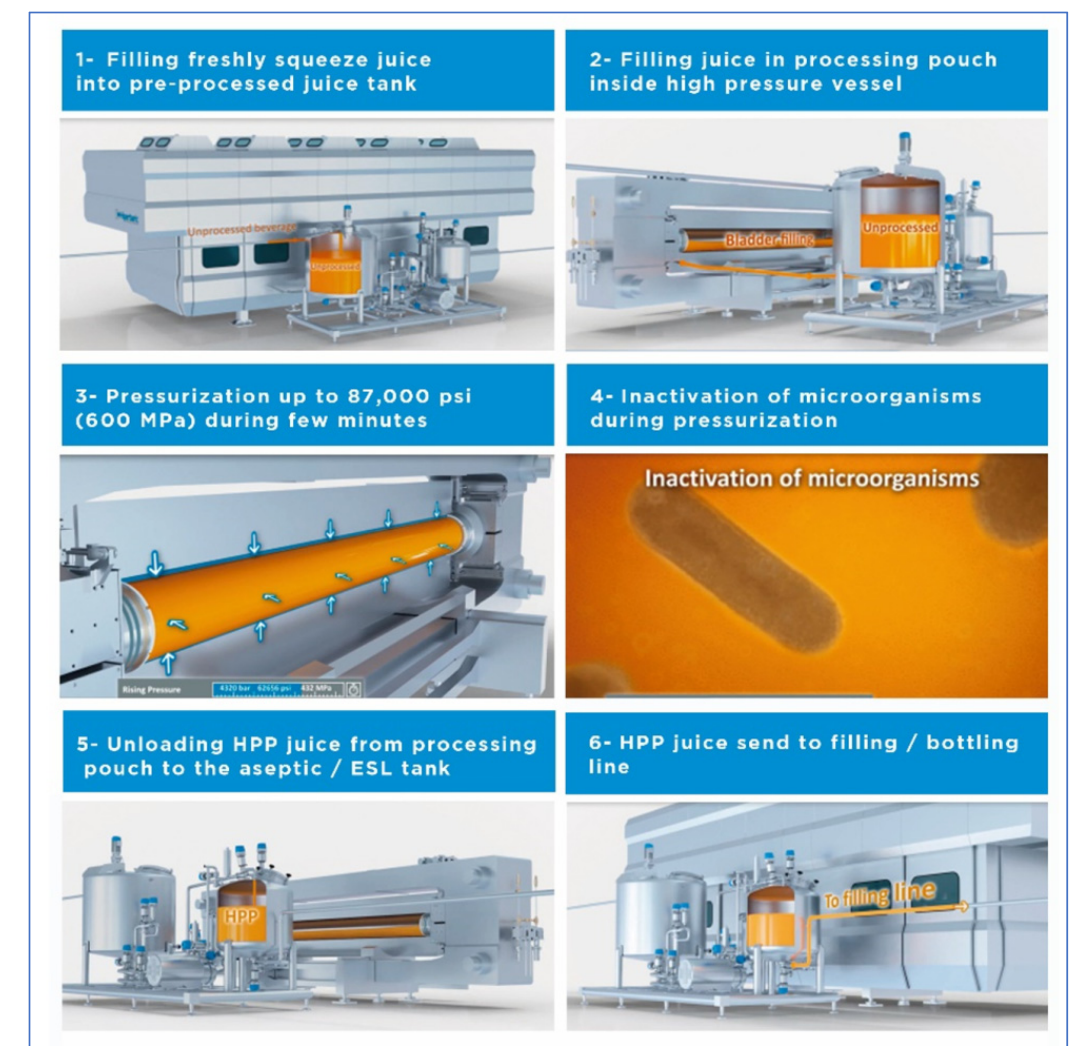
Figure 4. HPP in-bulk processing